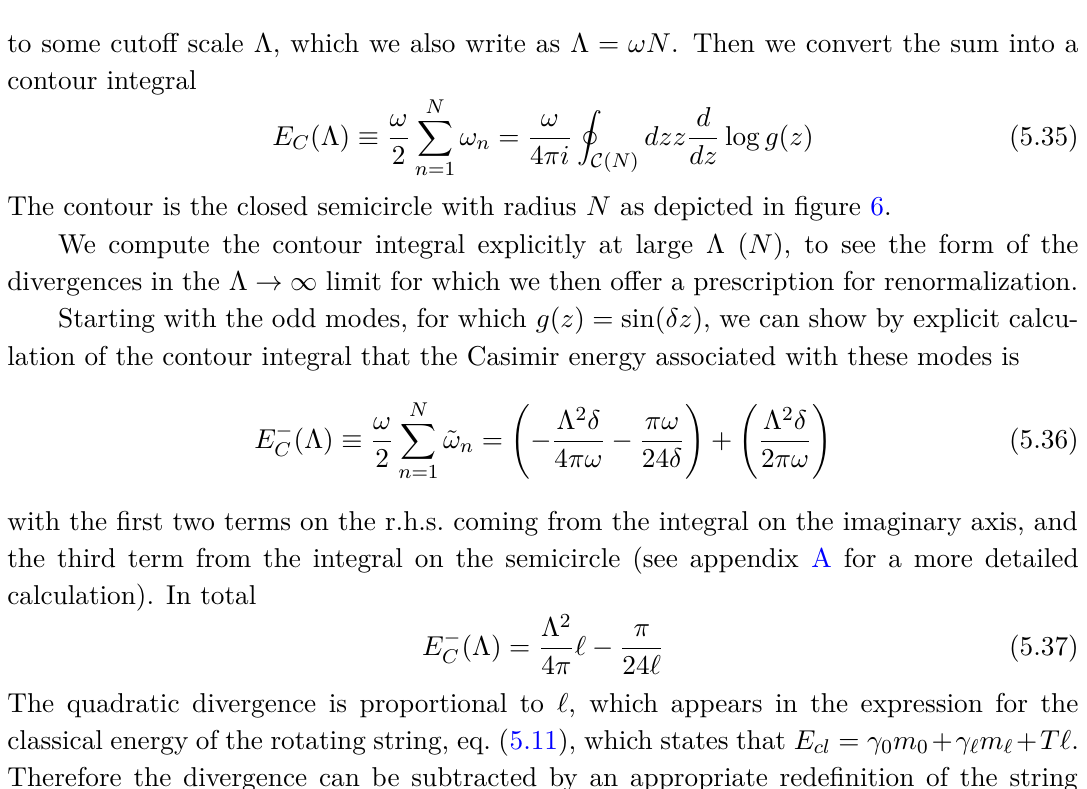
Figure 6 . Semicircular contour over which we carry out the integral that will sum over the eigenfrequencies on the positive real